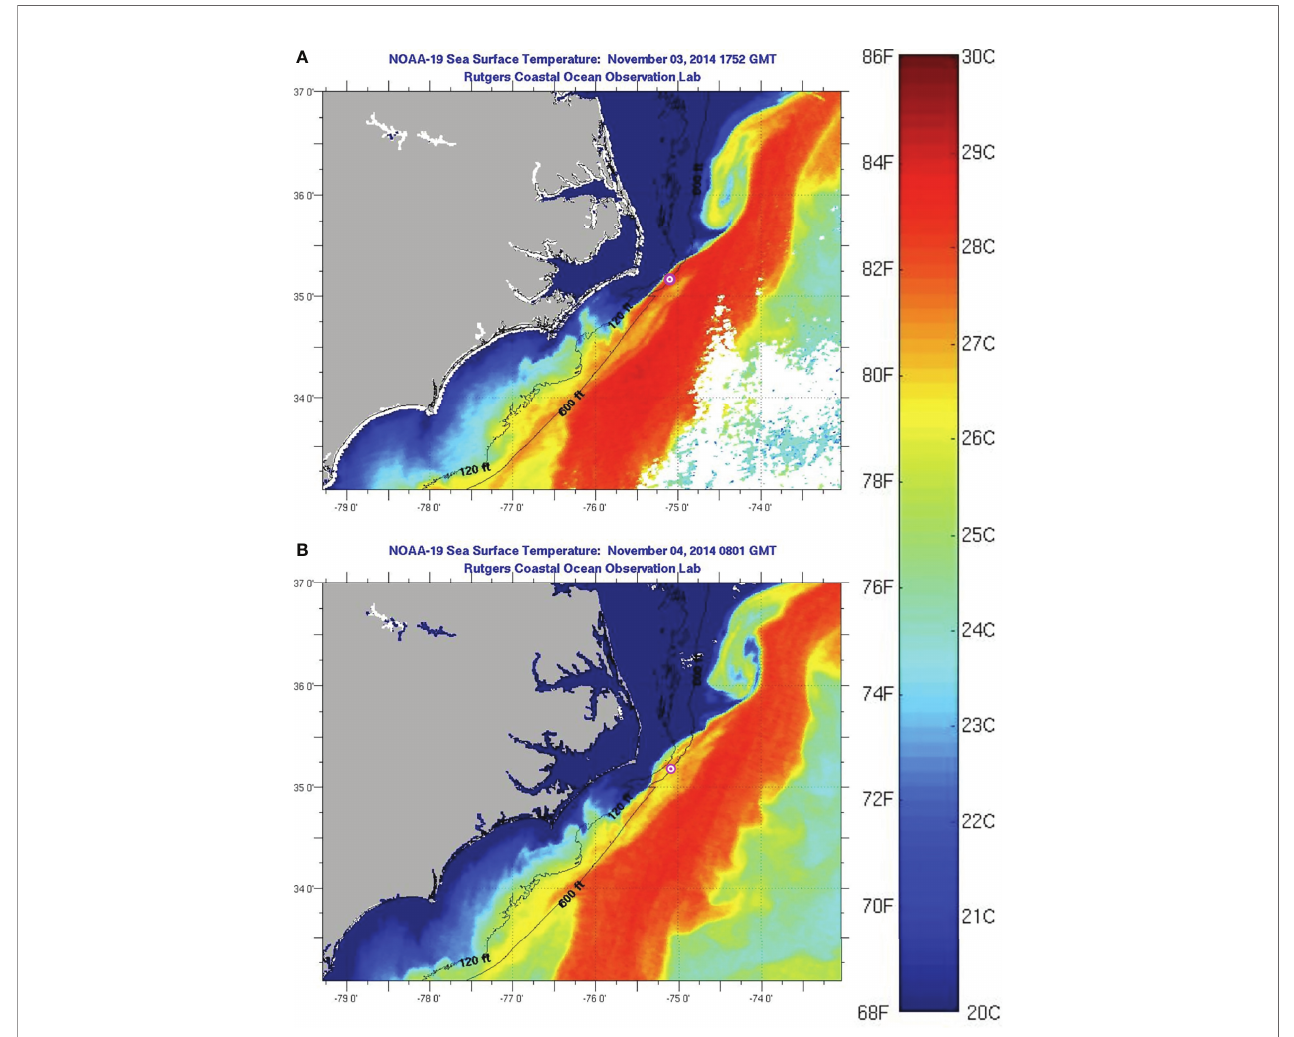
FIGURE 13 | SST image on November 3rd at 17:52 GMT and a day later on November 4th at 18:01 GMT. The ADCP location is marked with a pink